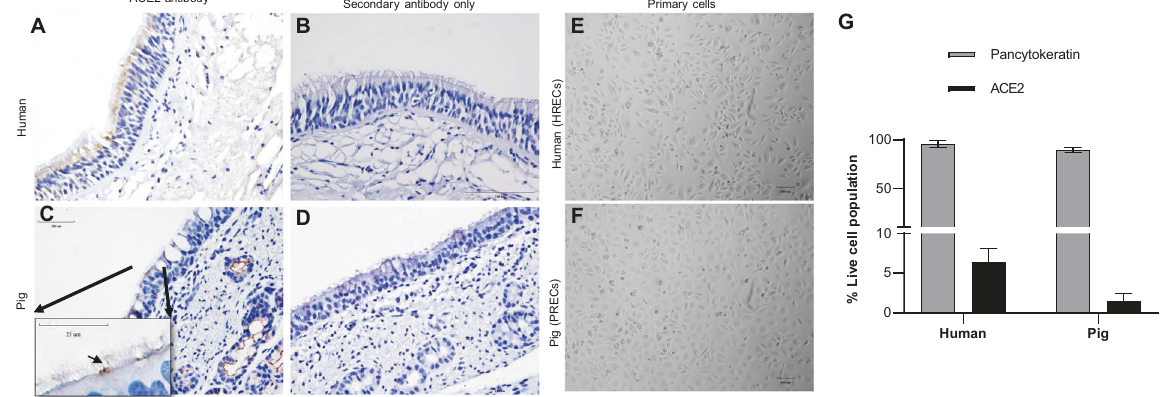
Fig. 1 Distribution of ACE2 receptor on PRECs and HRECs, and corresponding trachea tissue sections. A – D Formalin- fi xed paraf fi n- embedded cross-sections of human and pig tracheal sections stained for ACE2 with ImmPRESS VR anti-mouse IgG horseradish peroxidase (HRP) polymer detection kit (MP-6402-15). Brown spots represent the presence of ACE2 receptor that interacted with speci fi c antibody is considered a positive expression, and the nucleus counterstained with hematoxylin is blue. Expression of ACE2 in human ( A ) and pig ( C ) trachea revealed by immunostaining with mouse anti-ACE2 monoclonal antibody (4 μ g/mL; sc-390851). Note the focal expression of ACE2 on the epithelial cells of pig trachea ( C ; arrow in inset image). B , D Corresponding negative control tissues sections stained with secondary anti- mouse HRP antibody only. Scale bar-100 μ m (inset 25 μ m). Pig ( n = 3); human ( n = 1). Microscopic morphology of primary human ( E ; HRECs) and pig ( F ; PRECs) respiratory epithelial cells. G Determination of pan-cytokeratin and ACE2 in HRECs and PRECs using fl ow cytometry. Cells stained with LIVE/DEAD ® Fixable Near-IR Dead Cell Stain Kit, and respective mouse monoclonal antibodies (epithelial cell marker pan- cytokeratin; 0.5 μ g/mL; MCA1907T); (ACE2; 4 μ g/mL; sc-390851,) incubated for 30 min followed by incubation with Alexa Fluor ® 647 Goat anti- mouse (15 μ g/mL) for another 30 min. Data was collected using an Attune NxT fl ow cytometer. A representative of 10,000 events were acquired and analyzed for each sample. Cells were gated for singlet population using forward (FSA) and side-scatter (SSA) properties, and the mean of percent live cell population was used to quantify the levels of pan-cytokeratin and ACE2 ( n = 4). The bar graph represents the mean